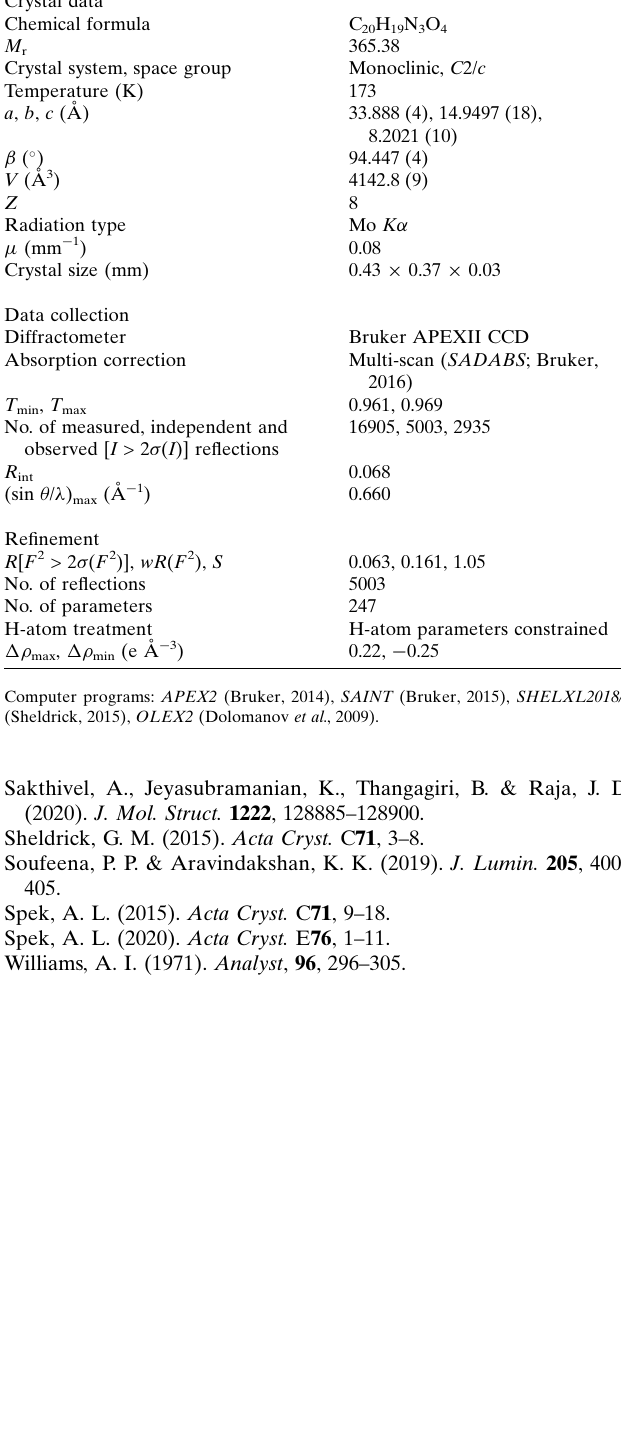
Table 2 Experimental details. Crystal data Chemical